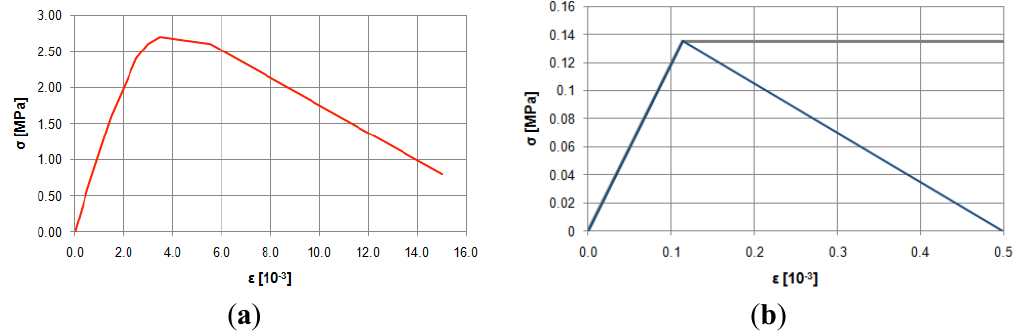
Figure 10. Constitutive relationships of masonry for Floors 1–2: ( a ) compression; ( b )